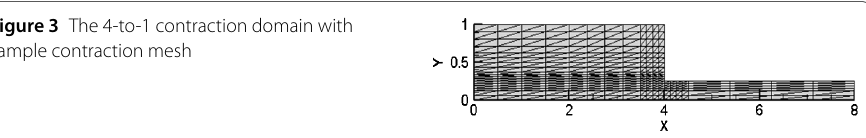
Figure 3 The 4-to-1 contraction domain with sample contraction